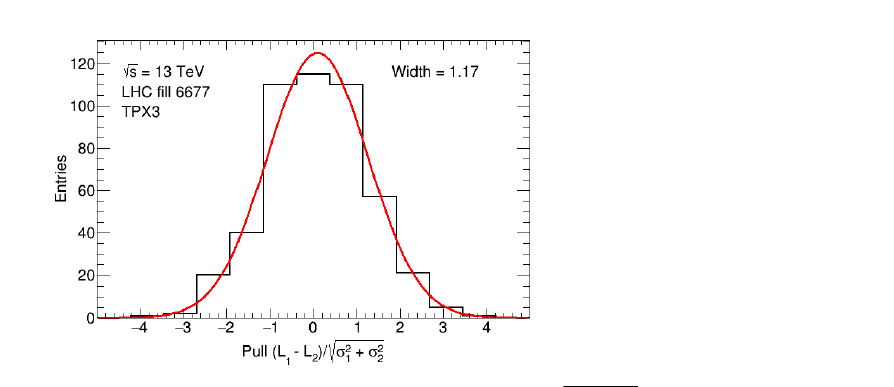
Figure 67. Pull distribution defined as ( L 1 − L 2 ) / from the cluster statistics for layer i . The data shown in Figure 66 are used (LHC fill 6677). Taken from Ref. [18].